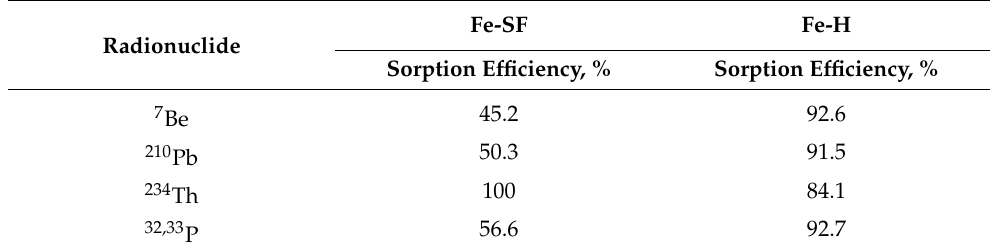
Table 5. Sorption efficiency of radionuclides in seawater when using Fe-SF and Fe-H sorbents. Fe-SF Fe-H Radionuclide Sorption Efficiency, % Sorption Efficiency,